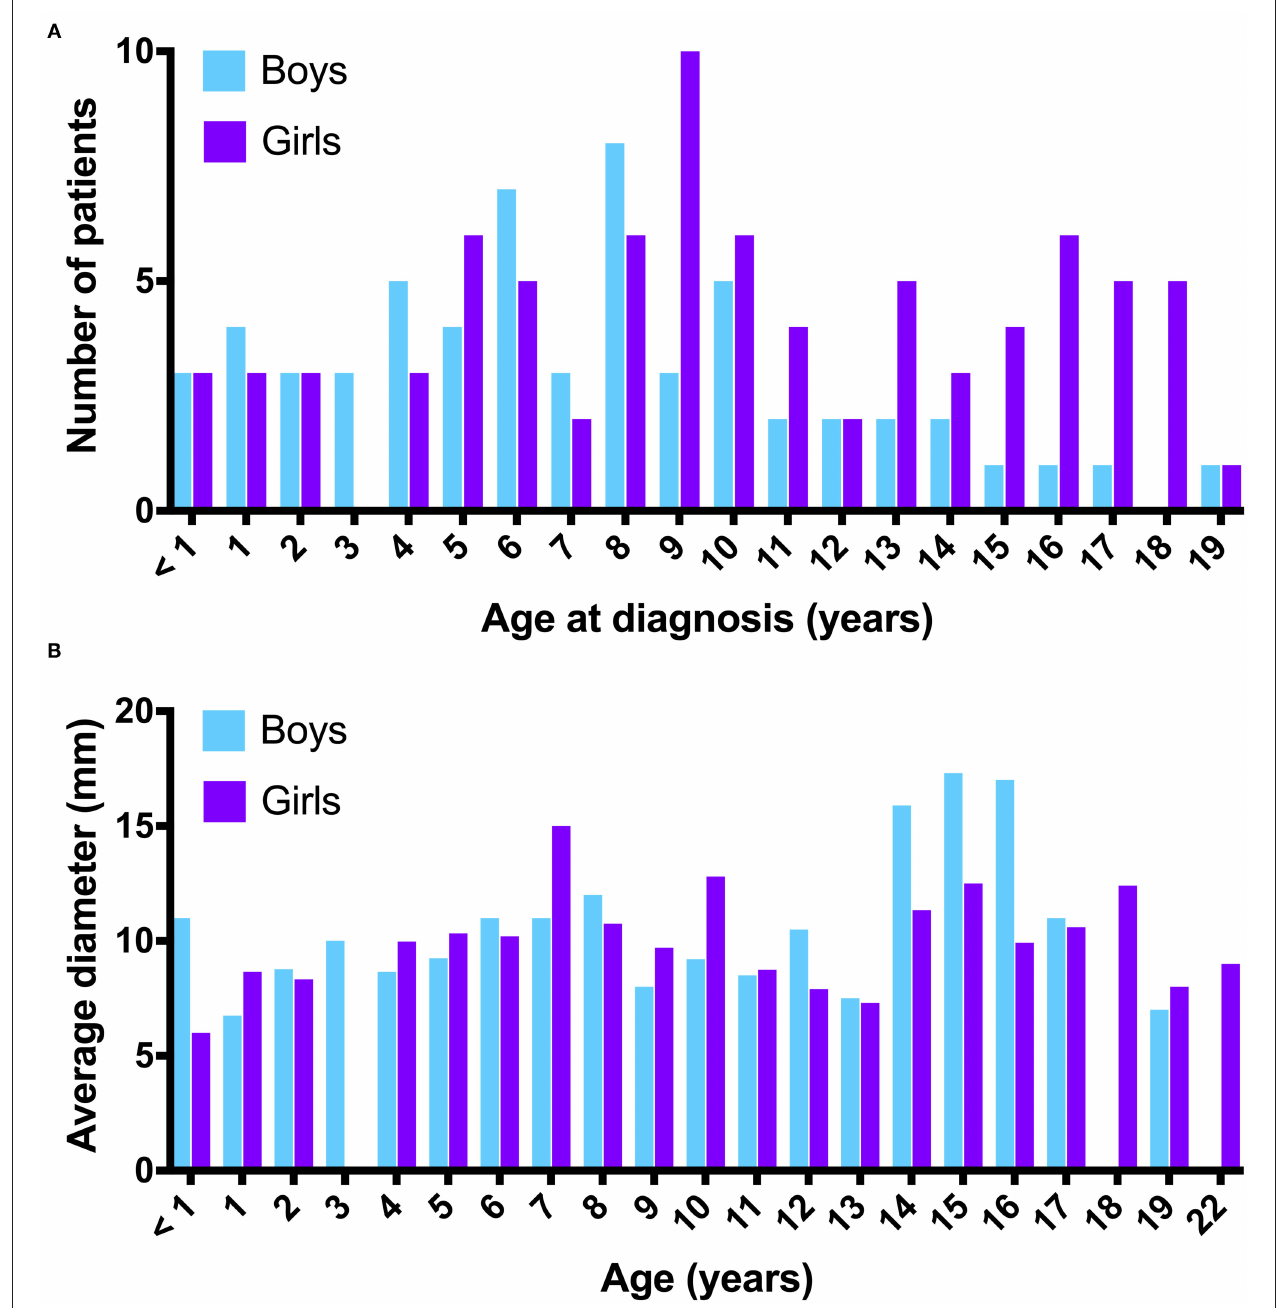
FIGURE 1 | (A) Number of patients with a PCL distributed by age at diagnosis (years) and sex. (B) Distribution of average PCL diameters in the cranio-caudal direction by age (years) and